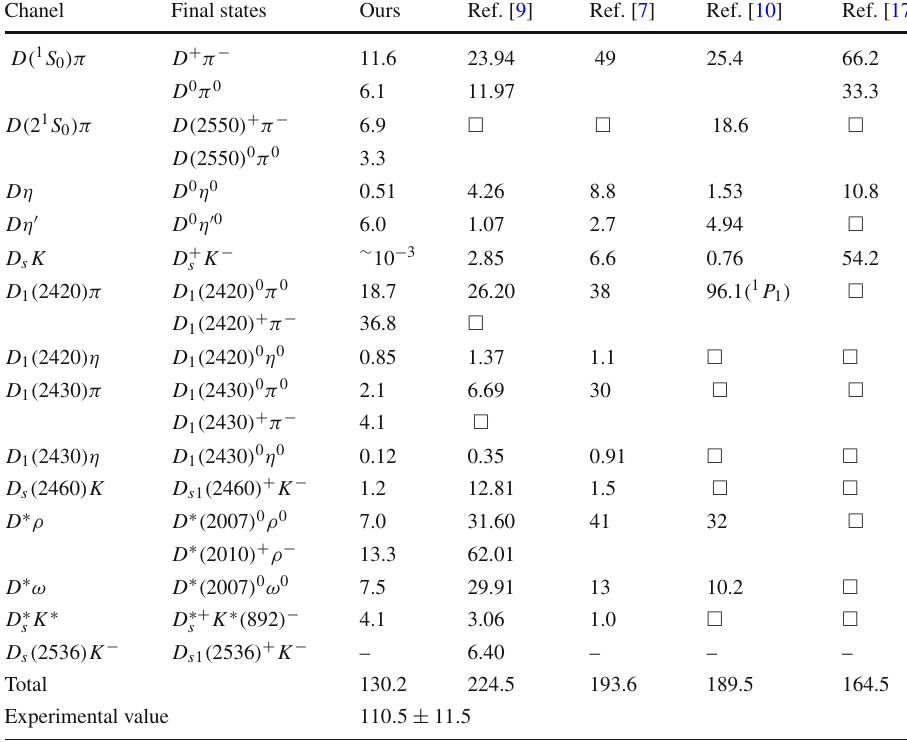
( 2400 ) and D ∗ ( 3000 ) change with the masses J 0